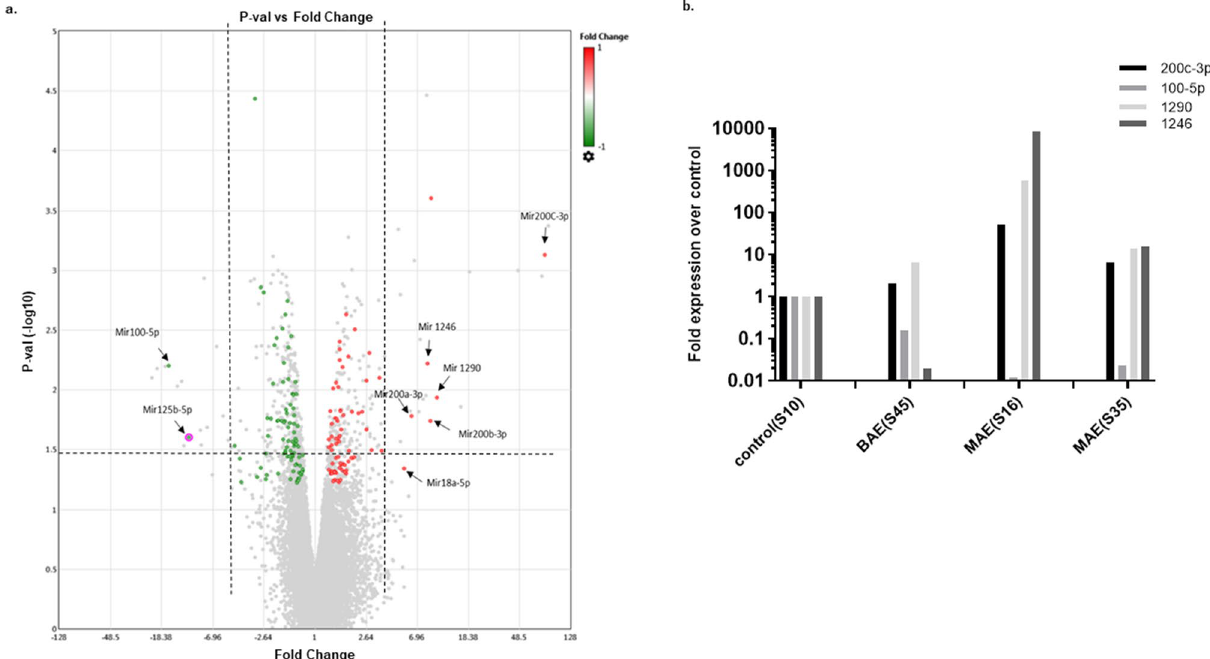
Figure 5. Quantitative Real-time PCR validation of miRNA in exosomes derived from ascitic supernatant. miRNA profiling was done using RNA isolated from BAE (benign ascitic supernatant derived exosomes) or MAE (malignant ascitic supernatant derived exosomes). P-value vs. fold change is depicted as a volcano plot generated using TAC software (ThermoFisher) ( a ). Volcano plot of significant expression of miR 200c-3p, miR 100-5p, miR 1290, and, miR 1246 over control in BAE (S45), and MAE (S16 and S35) ( b ).